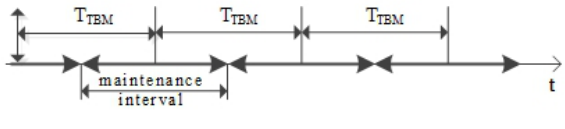
Fig. 2. TBM maintenance